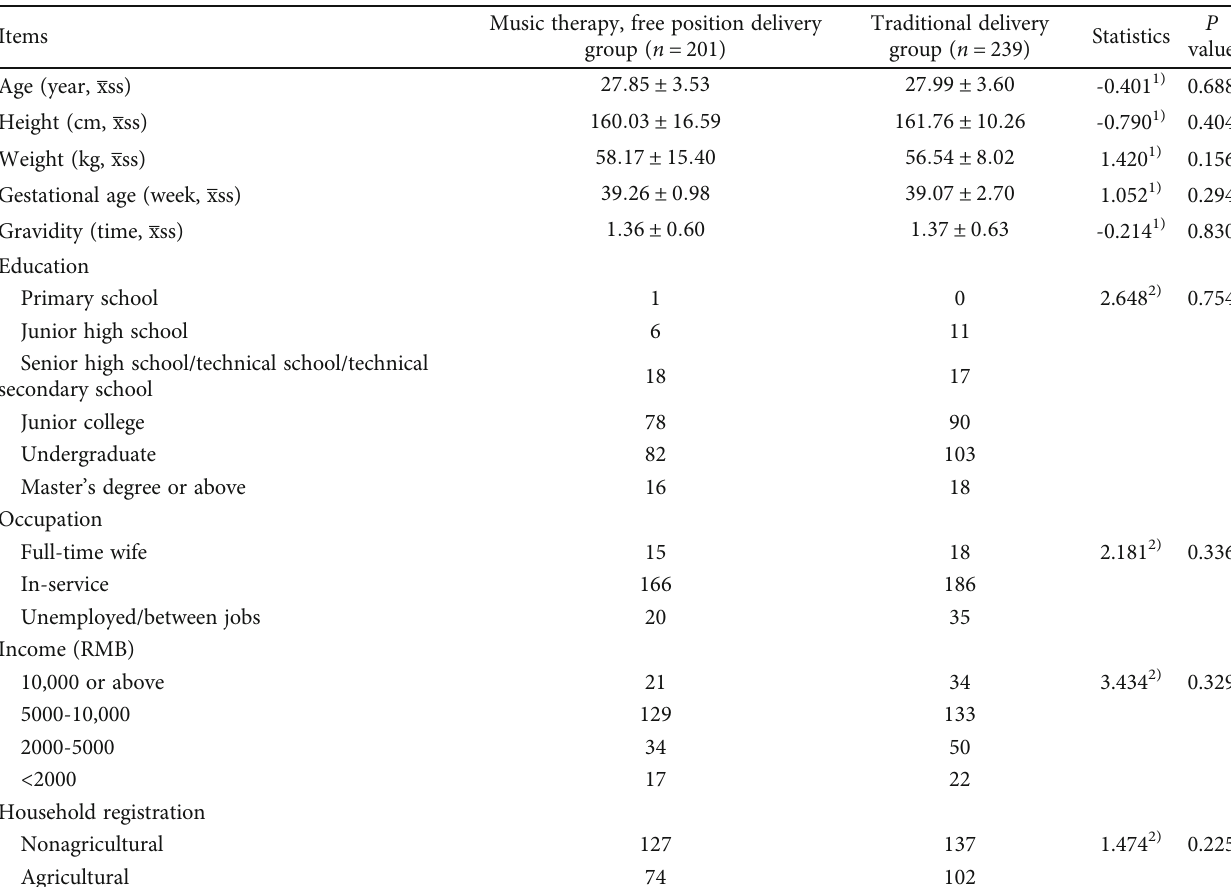
Table 1: General information of parturients in the two